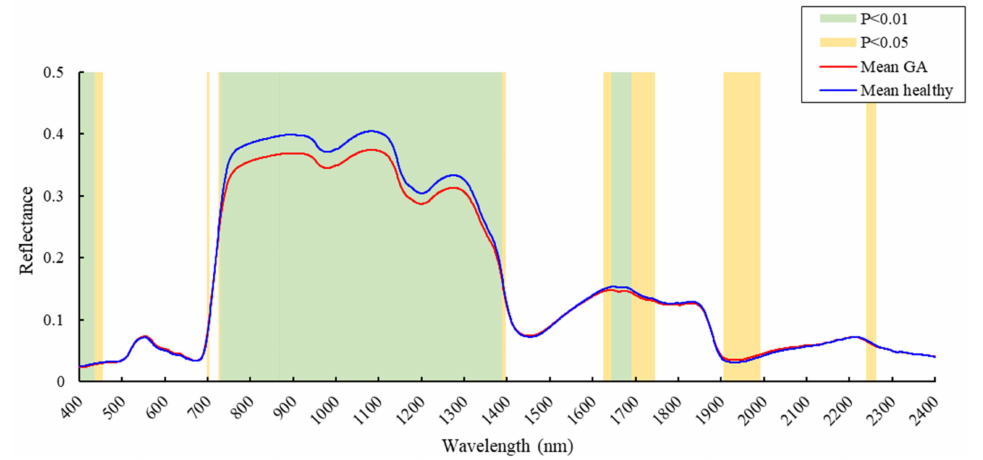
Figure 5. Mean reflectance of GA stage and healthy trees. The color areas indicate significant differences in the reflectance of